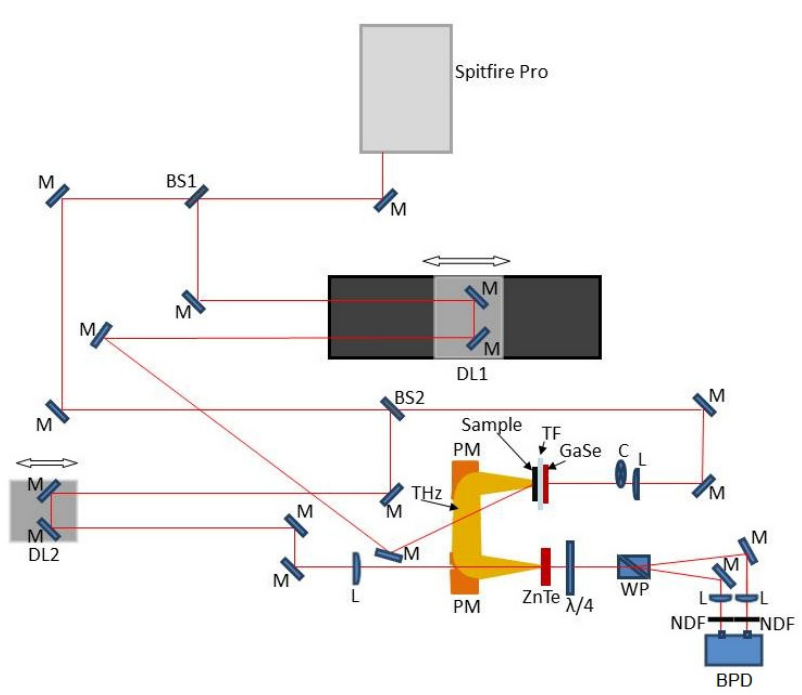
Figure 1. Scheme of the experimental setup: L—lens; M—mirror; BS1, BS2—beam splitters; DL1, DL2—delay lines; PM—parabolic mirror; TF—teflon filter; λ /4—quarterwave plate; WP—Wollaston prism; NDF—neutral density filter; BPD—balanced photodetector and C—mechanical chopper.